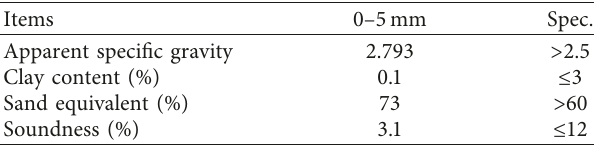
Table 4: Physical properties of fine limestone.